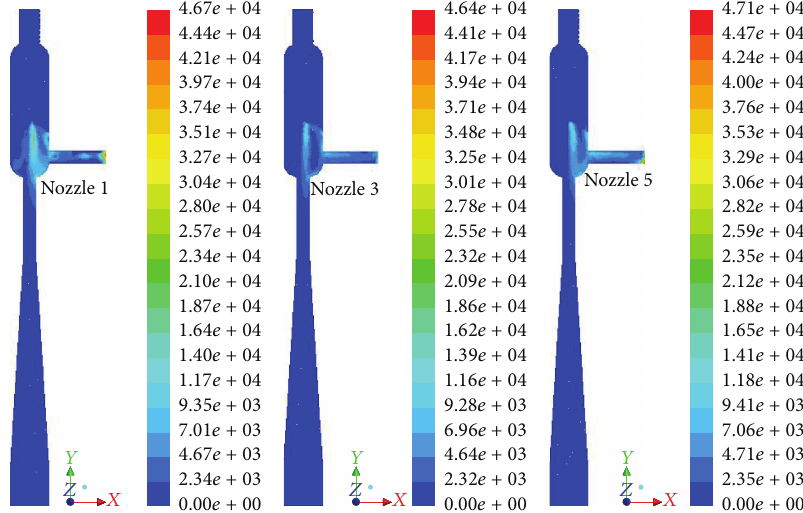
Figure 21: Contour of the interfacial area on middle plane for nozzles 1, 3, and 5.